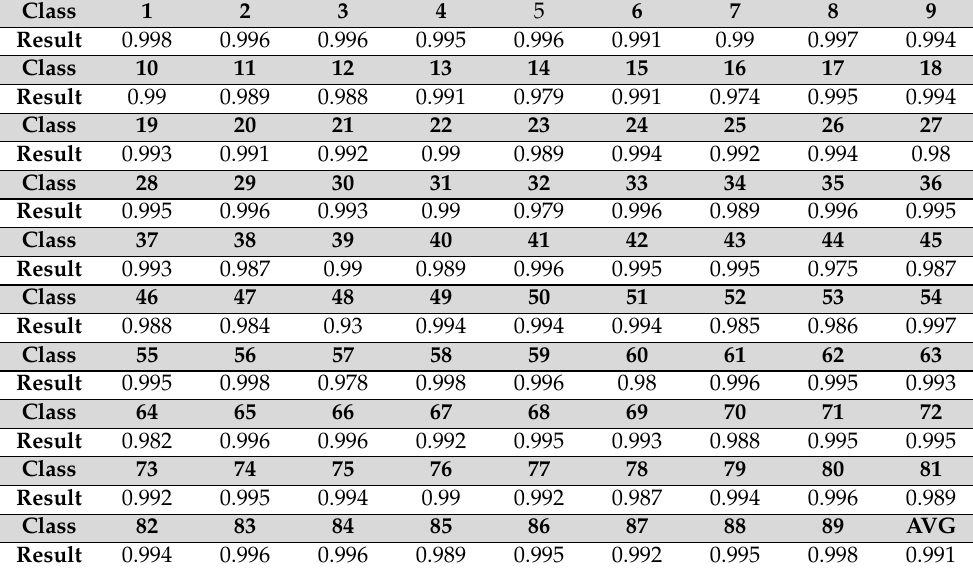
Table 2. Cosine similarity measurement results by experimentee.